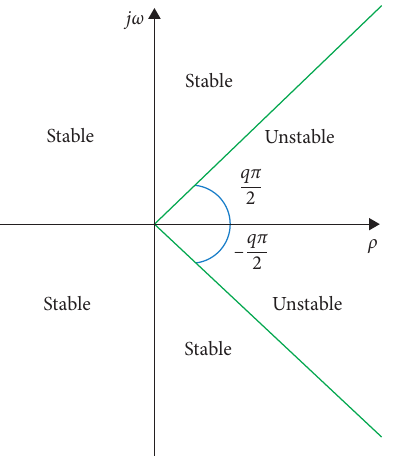
Figure 1: Stability region in a fractional-order linear time-in- variant system for 0 < q < 1.